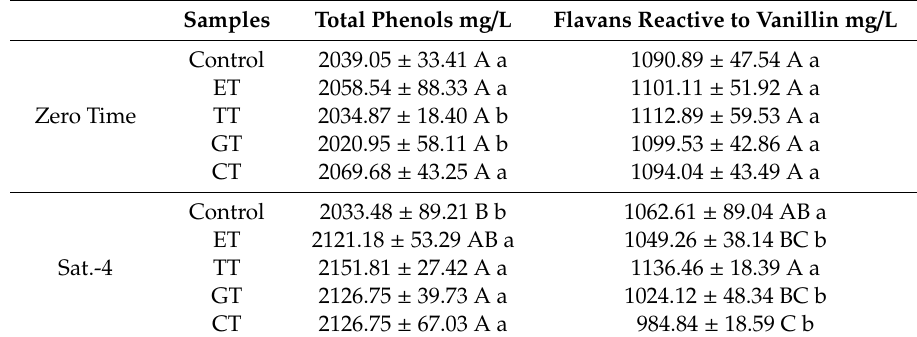
Table 3. Total phenols, flavans reactive to vanillin and tannins reactive to